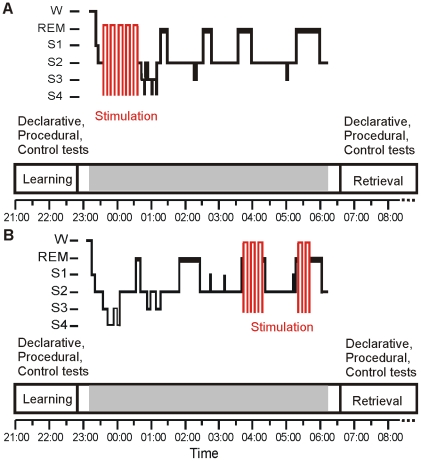
Time line of the two experiments.(A) Theta-tDCS during NonREM sleep (NonREM Experiment) and (B) during REM sleep (REM Experiment). Respective upper panels show representative individual sleep profiles (W: wake, REM: REM sleep, S1–S4: NonREM sleep stages 1–4) and periods of stimulation. Lower parts indicate Learning and Retrieval periods for memory testing on declarative and procedural tasks. The horizontal gray bar indicates lights out.